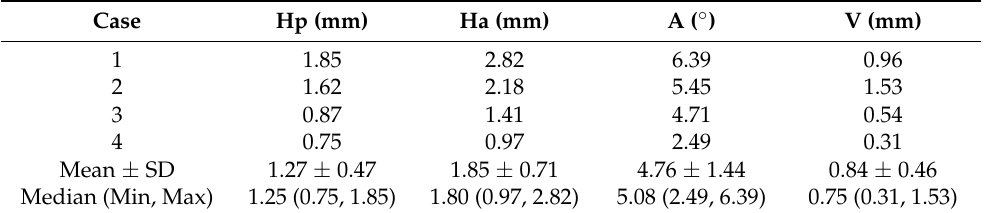
Table 2. Parameters showing deviation between virtually planned and actually placed implants.